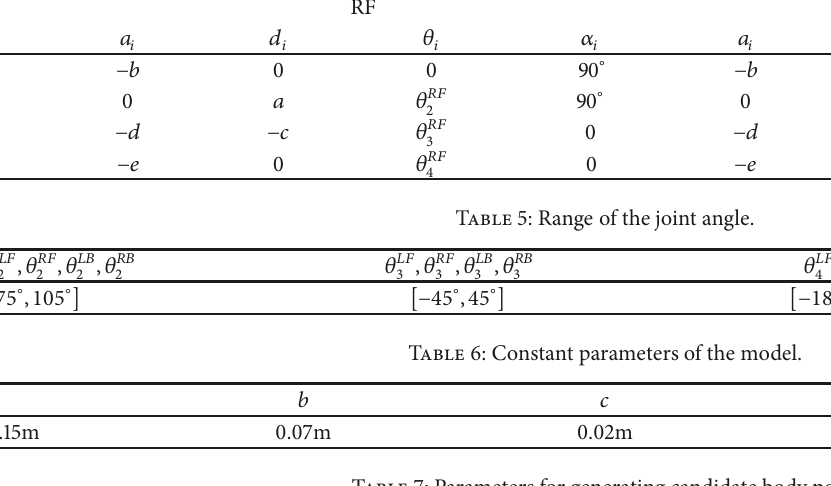
Table 7: Parameters for generating candidate body